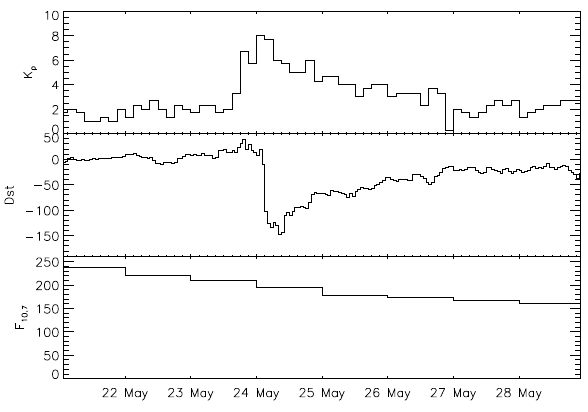
Fig. 1. Geomagnetic and solar indices for 21 May to 28 May 2000, indicating the geomagnetic storm on 24 May. (Major ticks mark 0 UT for each